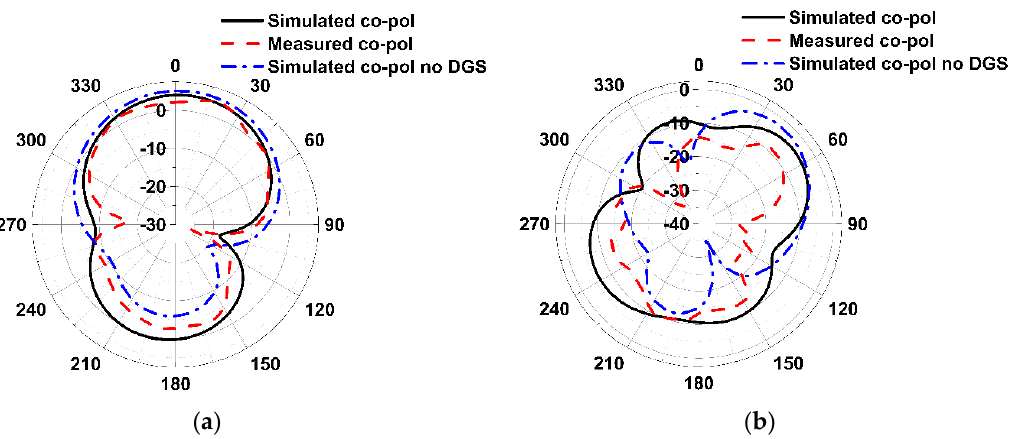
Figure 17. The radiation patterns in the YZ-plane. ( a ) 3.532 GHz, 3.736 GHz (no_DGS); ( b ) 6.835 GHz, 6.074 GHz (no_DGS).